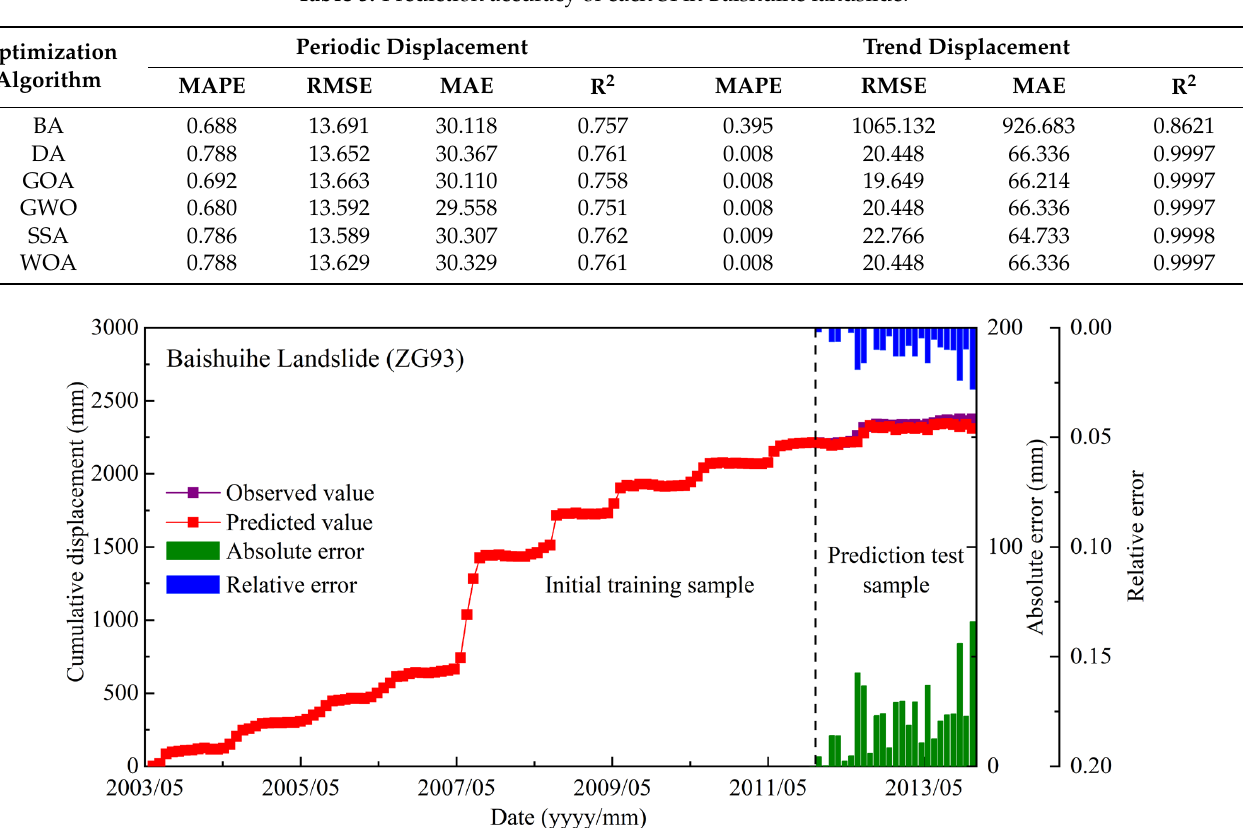
Table 5. Prediction accuracy of each SI in Baishuihe landslide.